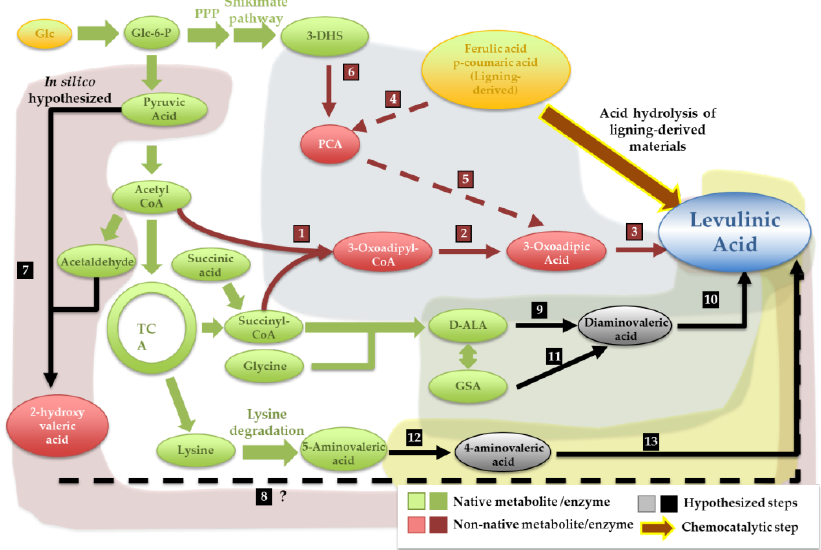
Figure 5. Biosynthetic levulinic acid-production pathways proposed and/or assembled in vivo to enable production in microbial cells. The pathways depicted in the picture include those already assembled in vivo (in yellow, blue and red) and those identified by metabolic retrobiosynthesis (in grey). Detailed identification of the enzymes involved in the different steps is provided in Sup- plementary Table S1. Enzymatic steps are numbered to match the enzymes detailed in Supple- mentary Table S1. Lumped reactions (involving multiple enzymatic steps) are depicted in dashed lines. For the pathways depicted in blue, one route starts with a β-ketoadipyl-CoA thiolase (1) and a 3-oxoadipyl-CoA transferase (2) and the other route entails the synthesis of protocatechuic acid (PCA) (4) and a dearomatization pathway (5), with both ending with a 3-oxoadipic acid decarbox- ylase (3). The red pathway entails an aldolase (7) and a series of redox reactions (8), while the green pathway starts with either a D-ALA transaminase (9) or a glutamate semialdehyde aminomutase (11) to yield 4,5-diaminovaleric acid, which is deaminated to LA by diaminovaleric ammonia lyase (10). The yellow pathway includes a 4-amino valeric aminomutase (12) and a 4-aminovaleric transaminase (13). 6. Bridging the Gap between CAs and Their More Economically Relevant Derivatives through the Assembly of Synthetic Pathways The market potential of CAs stems from their use as platforms for the production of various bulk chemicals that can afterward be explored by different industries. While the bio-based production of CAs has been receiving a lot of attention, much less has been given on how to enable the production of these derivatives. The more used approach involves the production of the CA in a microbe and its later conversion into the deriva- tive using one (or more) chemical step(s). The above-described production of adipic acid from catalytic hydrogenation of muconic acid and the production of acrylate from mi- crobially produced 3-hydroxypropionic acid [67] or from lactic acid [68] (the strategy pursued by Cargill to implement bio-based production of acrylic acid [69]) are paradig- matic examples of those combined biochemical-chemical approaches. This strategy has the advantage of maintaining flexibility since the same platform molecule is re-routed for multiple applications. However, the conversion steps between the CA and their deriva- tives can also have a strong environmental impact (for example, by using or producing hazardous reagents or residues), and it may also face problems concerning the purity of the product (for example, if it results in the formation of racemic mixtures that can be hard to separate) that complicates downstream processing. For those CAs in which eco- nomic turnover is narrow, these additional problems can pose serious constraints to in-